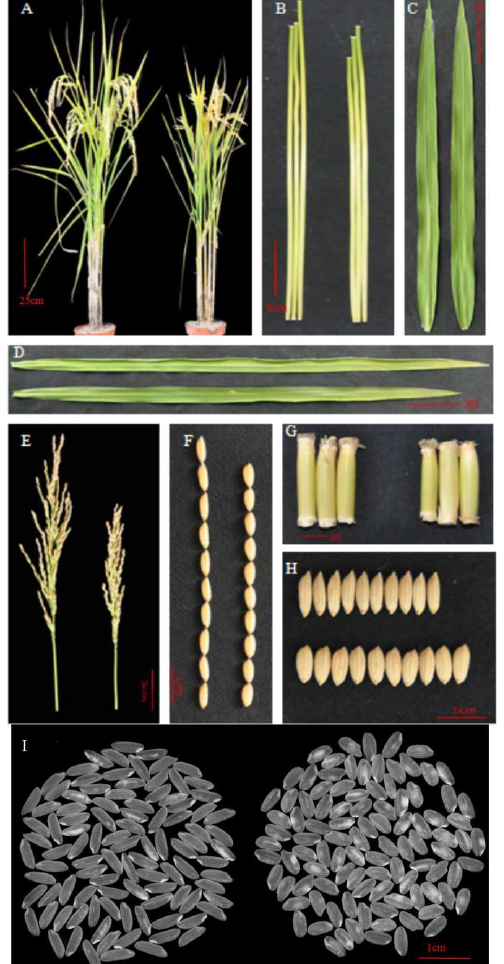
Figure 5. Agronomic traits of paired NILs for qGS7 . ( A ) Gross morphology of qGS7 N643 (left) and qGS7 LH (right), bar = 25 cm. ( B ) Top internode diameter qGS7 N643 (left) and qGS7 LH (right), bar = 5 cm. ( C ) Flag leave length of qGS7 N643 (left) and qGS7 LH (right), bar = 5 cm. ( D ) Second leaf length from the top of qGS7 N643 (up) and qGS7 LH (down), bar = 5 cm. ( E ) Main panicle of qGS7 N643 (left) and qGS7 LH (right), bar = 5 cm. ( F ) Grain length of qGS7 N643 (left) and qGS7 LH (right), bar = 1 cm. ( G ) Stem diameter of qGS7 N643 (left) and qGS7 LH (right), bar = 1 cm. ( H ) Grain width of qGS7 N643 (up) and qGS7 LH (down), bar = 1 cm. ( I ) Comparison of the appearance of milled rice between the qGS7 N643 (left) and qGS7 LH (right), bar = 1 cm.